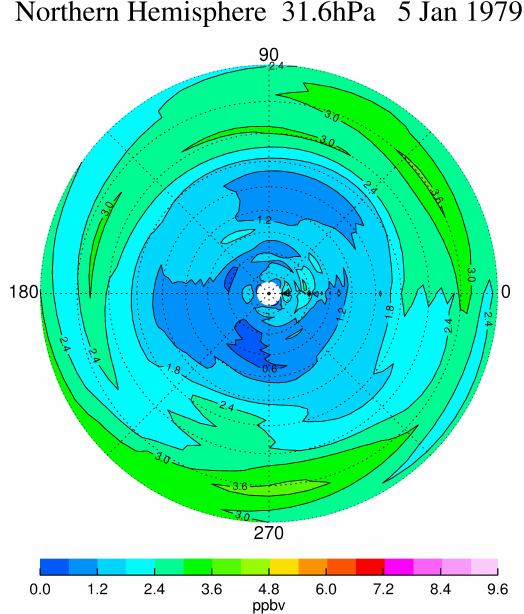
Fig. 9. V6 descending NO 2 inppbv for 5 January 1979. Bluish regions are low values and greenish regions are high values; contour interval is